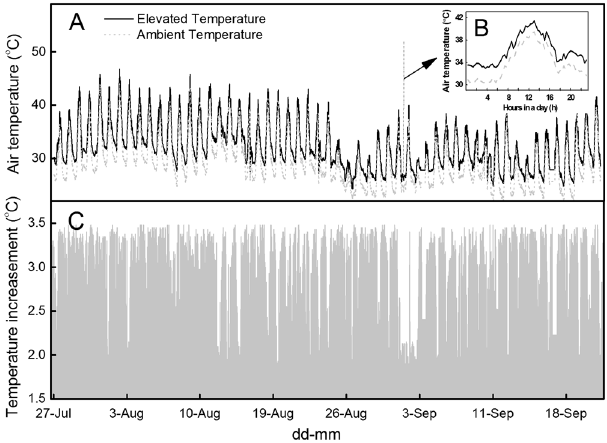
Figure 3. Air temperature recording. Air temperature in two regions during flowering season (Jul-27 to Sep-21, A ), within 24 hours ( B ), and the temperature increment between two treatments during flowering season ( C ) in 2010. Temperature data were recorded at every 20 min by the temperature control device ( A , C ). A consistent air temperature increment by 2–3.5 °C existed all across fiber development ( C ). The mean daily air temperature (MDT) and other relative indices were calculated by the temperature control